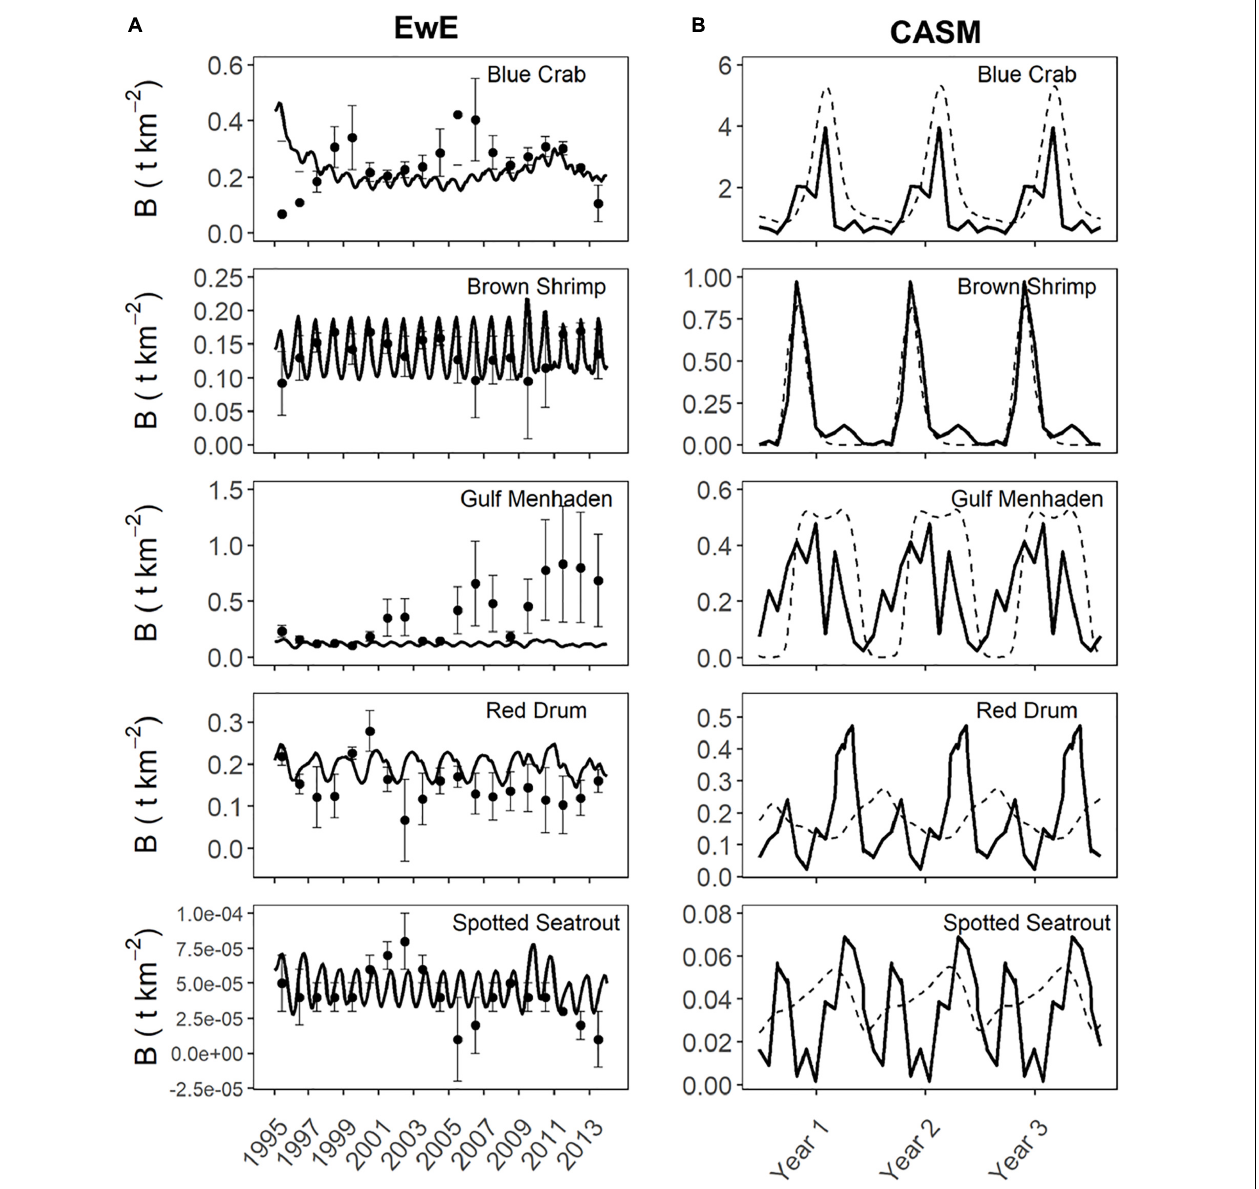
FIGURE 4 | Predicted versus observed biomasses over time from selected species represented in both the Ecosim (A) and CASM (B) calibration simulations. Observed biomasses were annual for Ecosim and daily for CASM. Both used the same monitoring data that was monthly, which were averaged for Ecosim and interpolated for CASM. Ecosim predictions were for the entire model domain, while CASM predicts were averaged over the polygons comprising the domain of the Barataria